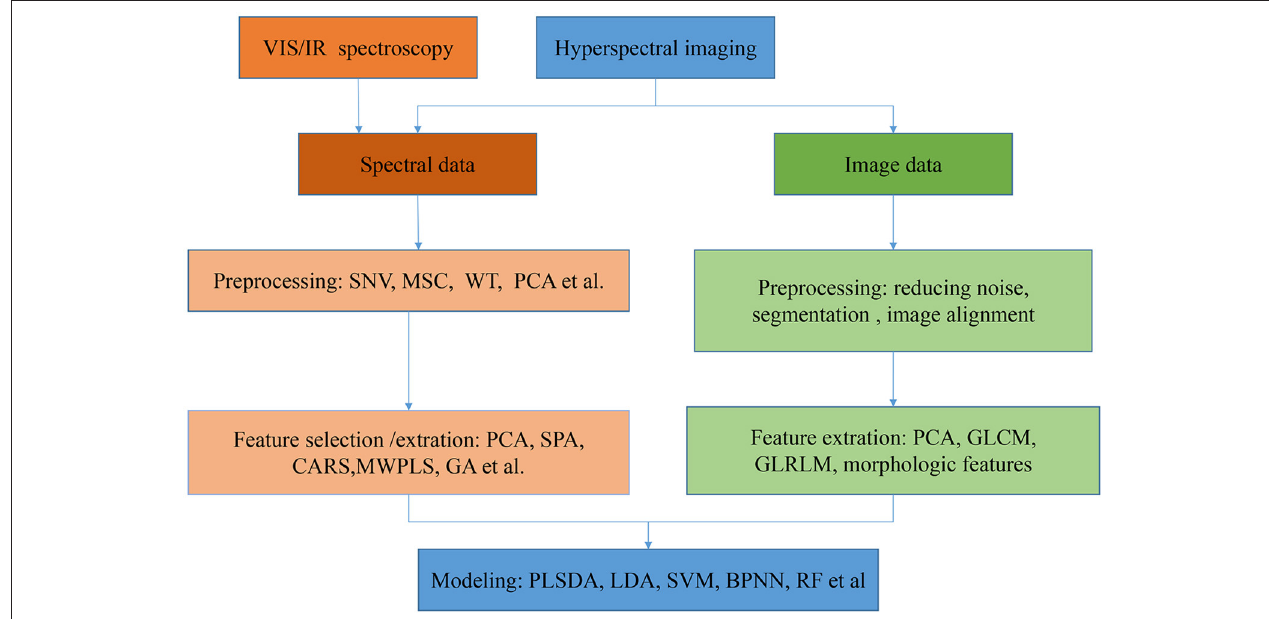
FIGURE 1 | The general flowchart of procedures for food varieties and geographical origins identification model